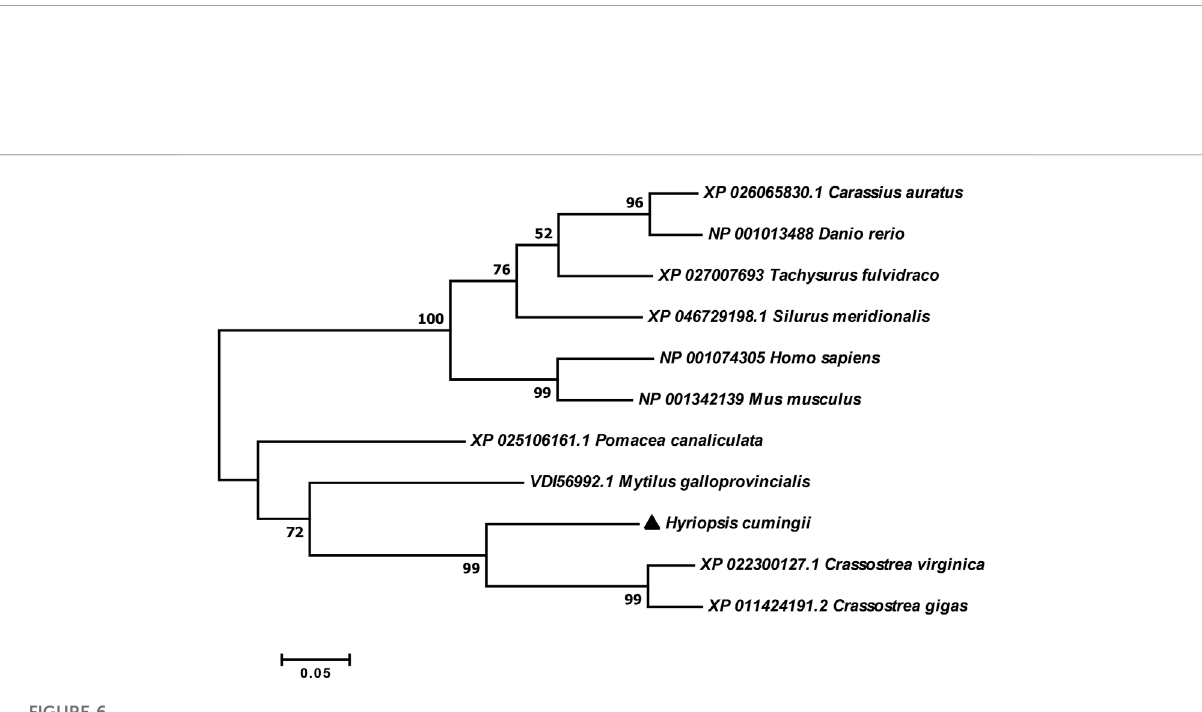
FIGURE 6 Phylogenetic tree of MEIG1 in different